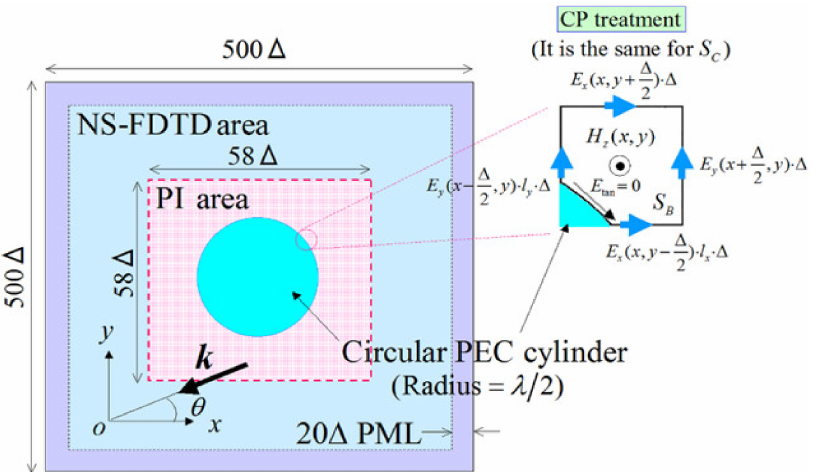
Figure 4. The computational domain for the RCS analysis of the infinite circular PEC cylinder with a radius of λ /2, concerning the validation of the 2D CP technique applied to the proposed PI concept in the NS-FDTD area terminated by a perfectly matched layer (PML) [58]. The structure is excited by a TE plane wave with λ = 1 m and an incident angle of θ inc = 0 ◦ , while all scattered-field components are obtained by means of the TF/SF formulation [8] in the NS-FDTD region.